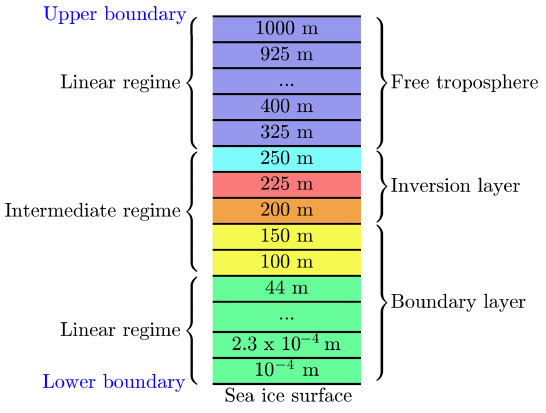
Figure 2. One-dimensional grid. Numbers are at the center of every numerical grid cell. The red grid cell resides inside the inversion layer. The grid cells at 200 and 250m are centered at the interface of the inversion layer.